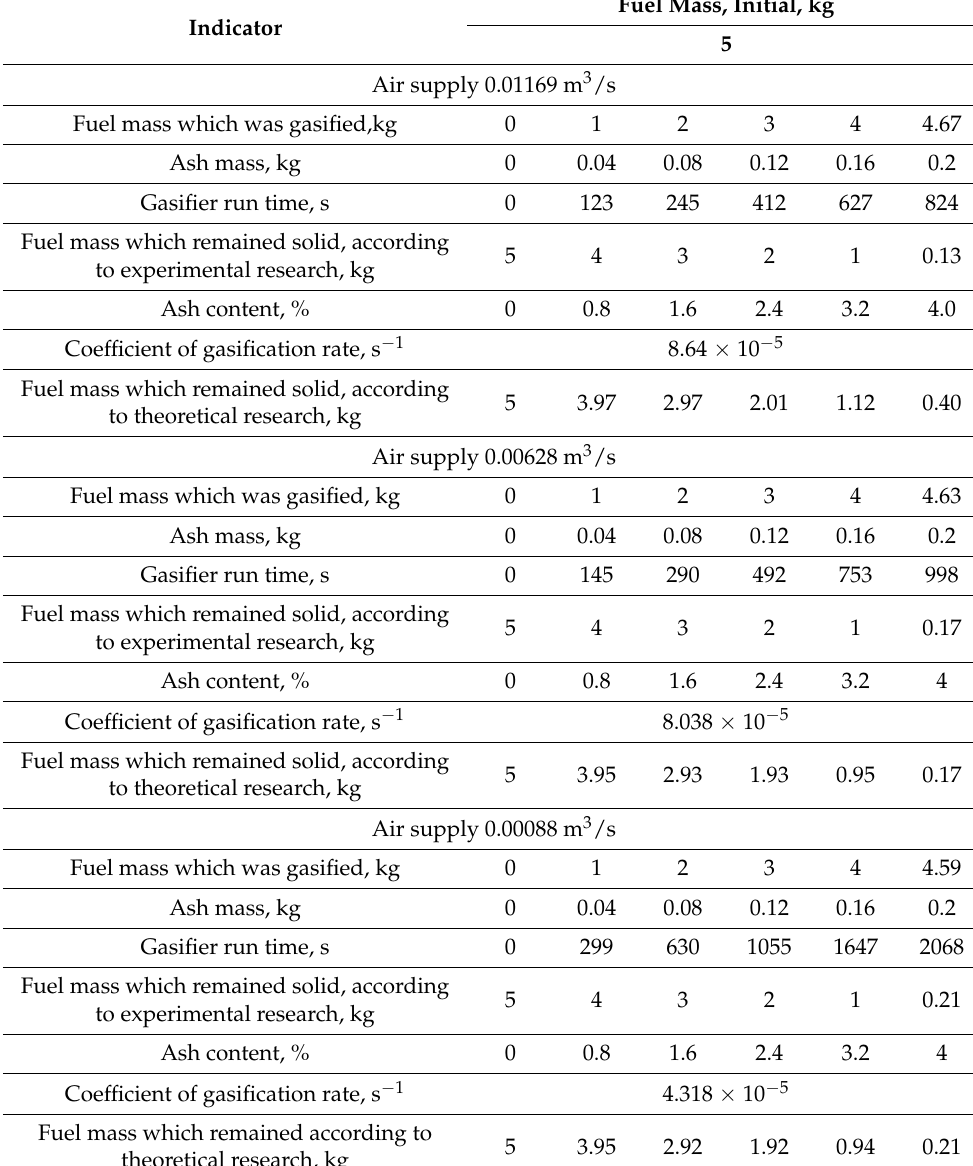
Table 3. Indicators of theoretical and experimental studies of the gasification rate of wood in